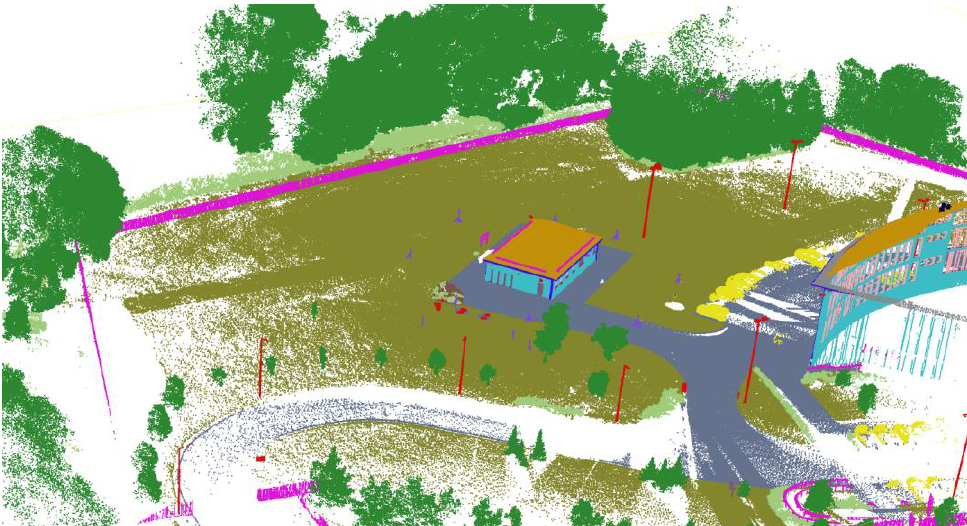
Figure 5. The overview of the manually classified TLS point cloud.